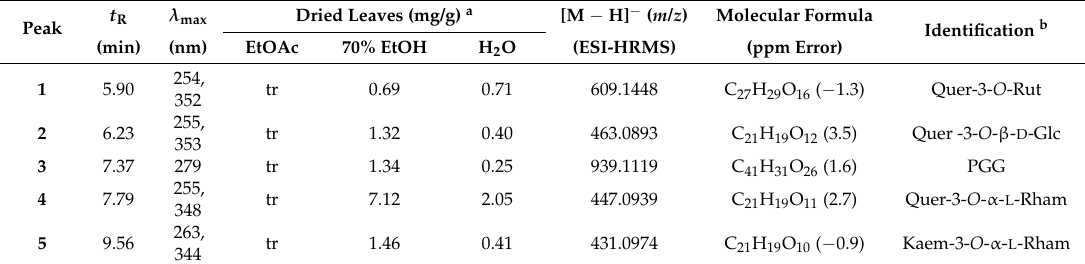
Figure 4. Representative chromatograms of 70% EtOH extract from the leaves of T. sinensis : ( A ) Photodiode array (PDA) chromatogram and ( B ) total ion current-base peak intensity (TIC-BPI) chromatogram. Table 2. Spectral characteristics and contents (mg/g) of the five investigated compounds in the leaves of T. sinensis .